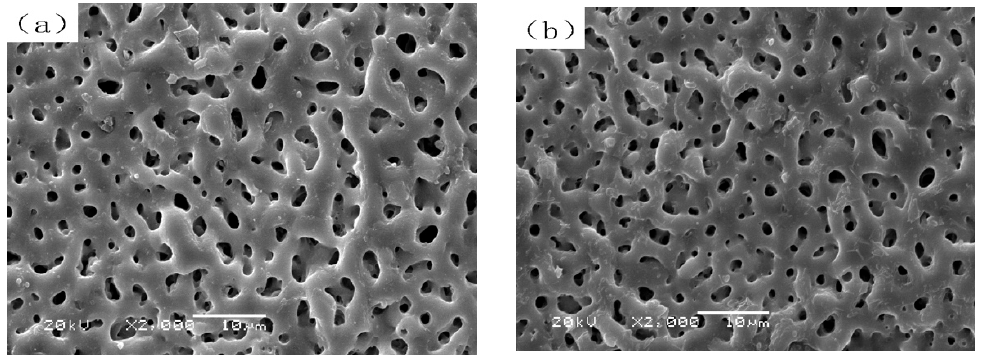
Figure 9. Surface morphology of MAO AZ91D Mg-alloy coatings by the voltage loading speed was: ( a ) 10 V/min and ( b ) 5 V/min.